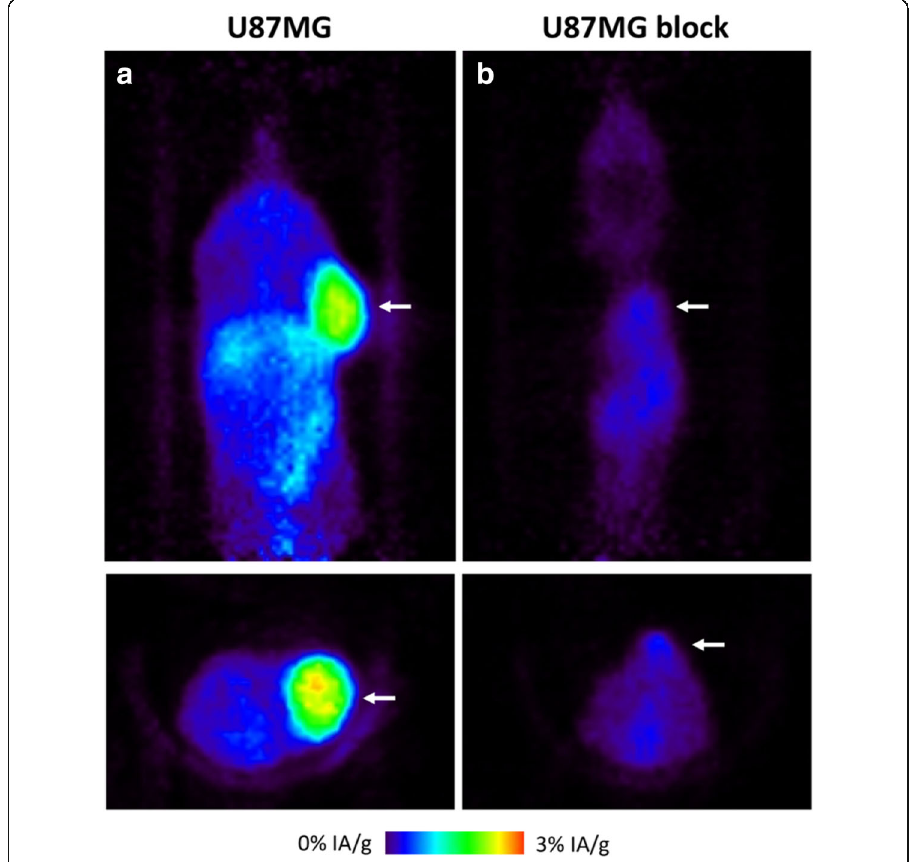
Fig. 2 a Representative coronal (top) and transverse (bottom) maximum intensity projections (MIPs) of [ 68 Ga] 3 at 1 h p.i. in U-87 MG tumor bearing mice. b Blocking studies confirmed the specificity of [ 68 Ga] 3 for α v ß 3 expression. White arrows indicate the